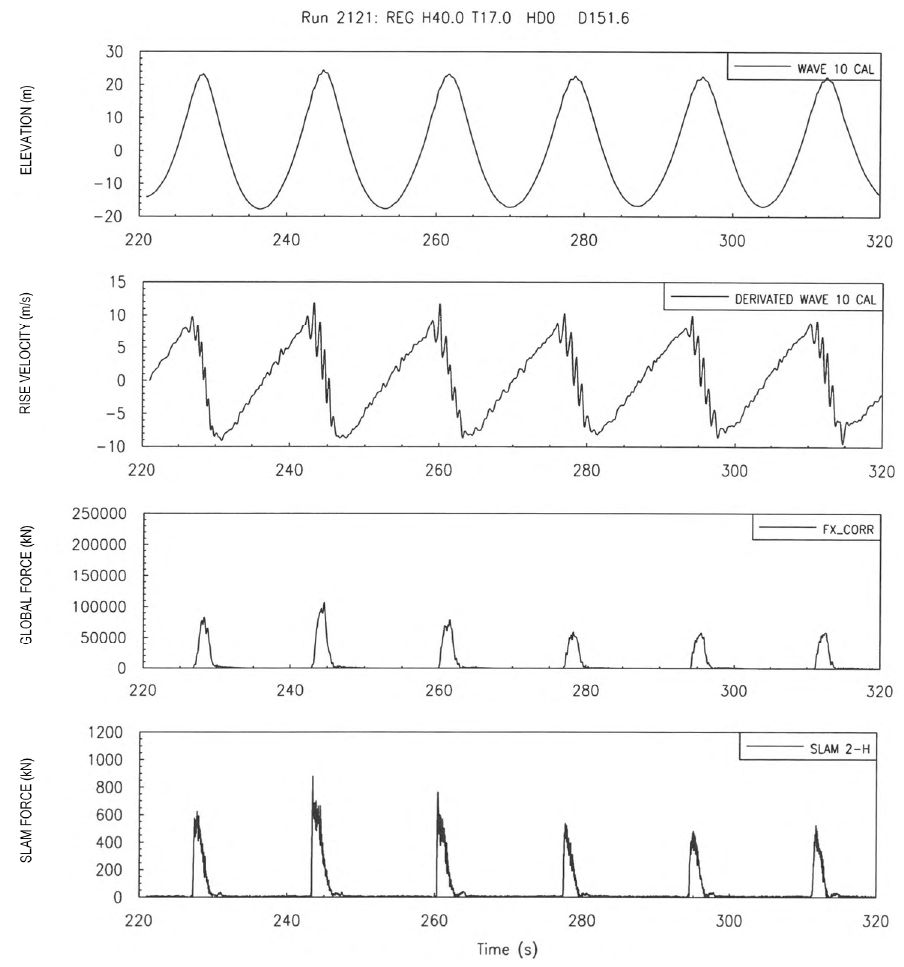
Figure 10. From top to bottom : Measured undisturbed wave elevation, derived rise velocity, global horizontal deck impact force, and local horizontal slamming forces, for a high regular wave H = 40 m, T = 17 s.